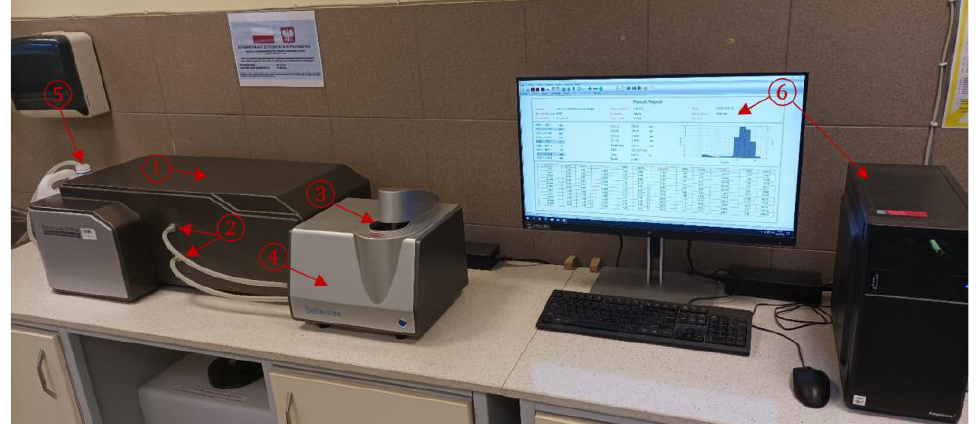
Figure 7. View of the Bettersizer S3 Plus laser particle size analyzer test stand located in the Department of Military Engineering and Infrastructure of the MUT, with markings of crucial components ① – ⑥.